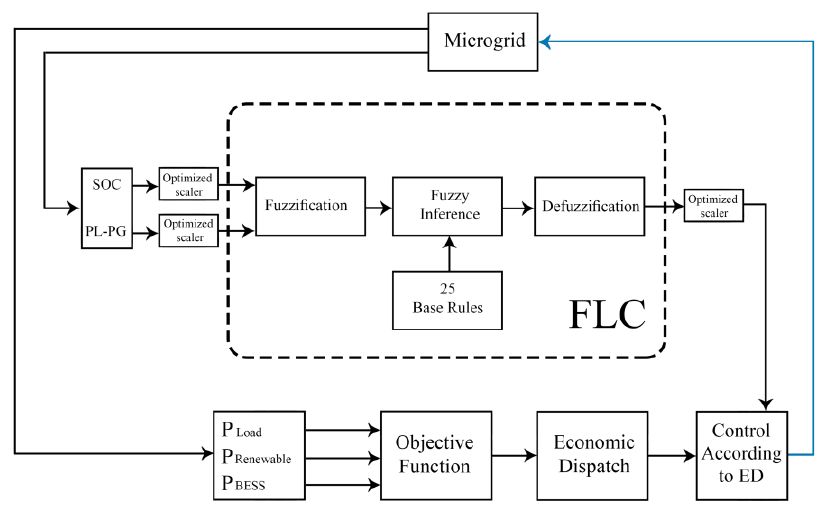
Figure 8. Proposed microgrid FLEMS with economic